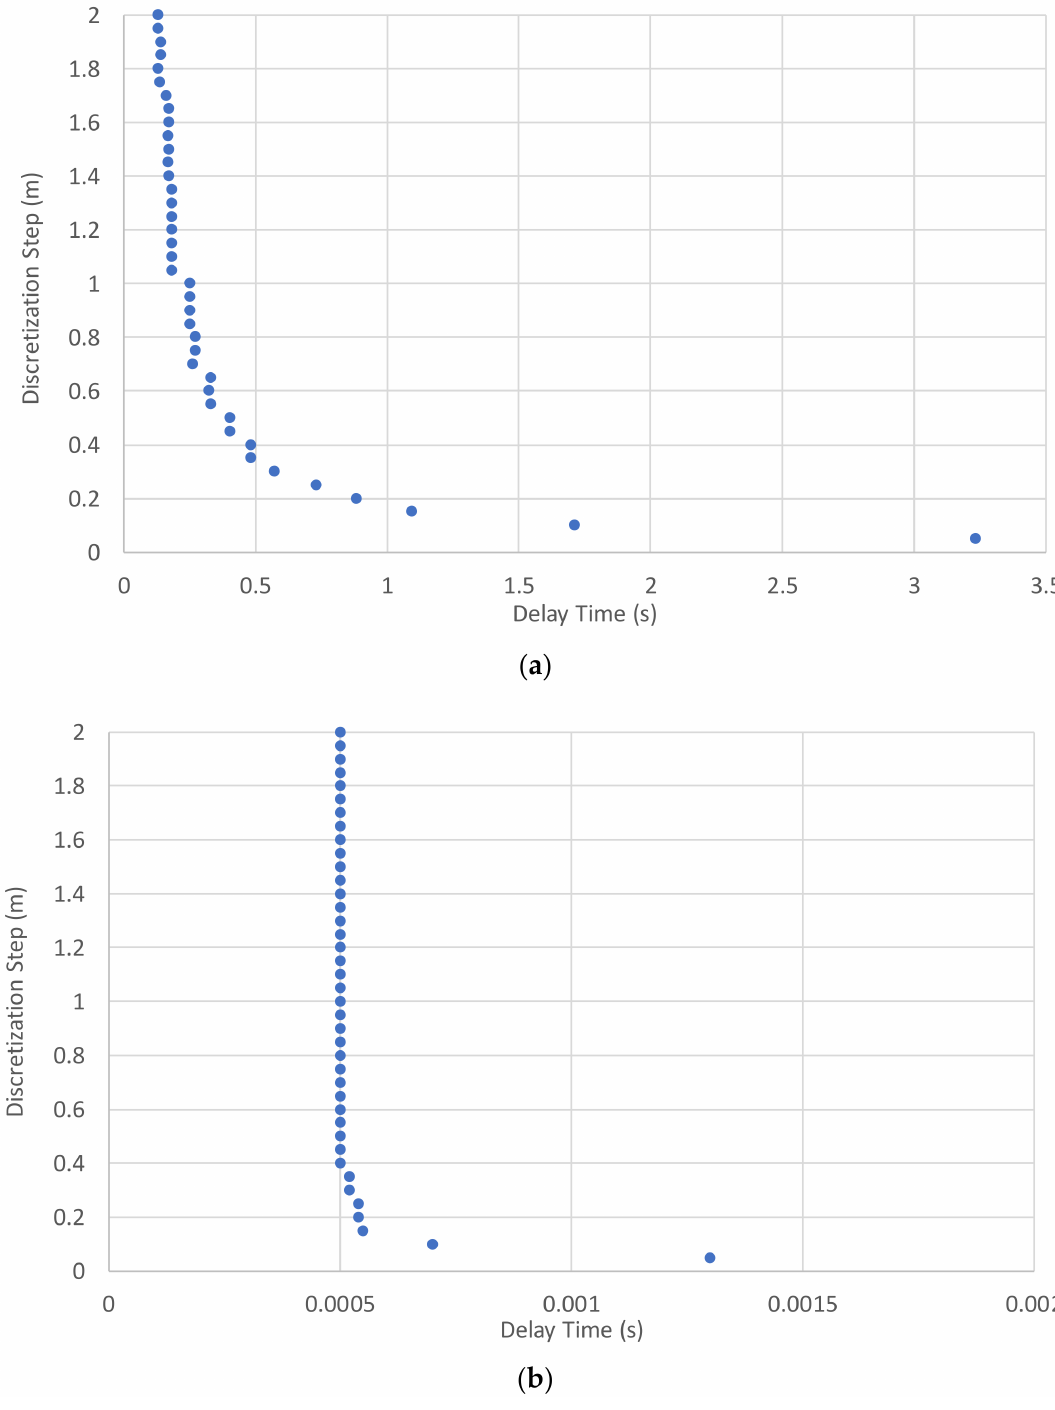
Figure 5. The delay time of the UEI tool in computing user-objects distances in the case of ( a ) continuously updating distance maps and ( b ) just computing user-object